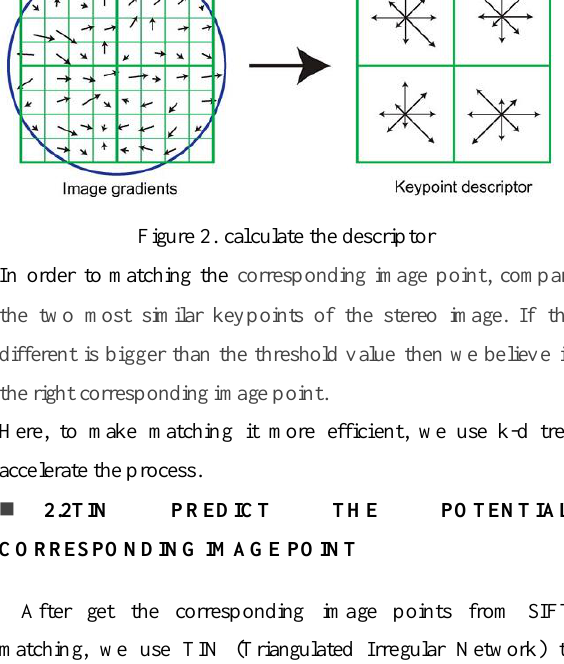
=the gray in left image x y =the gray in right image h , h =the variates in 01 11